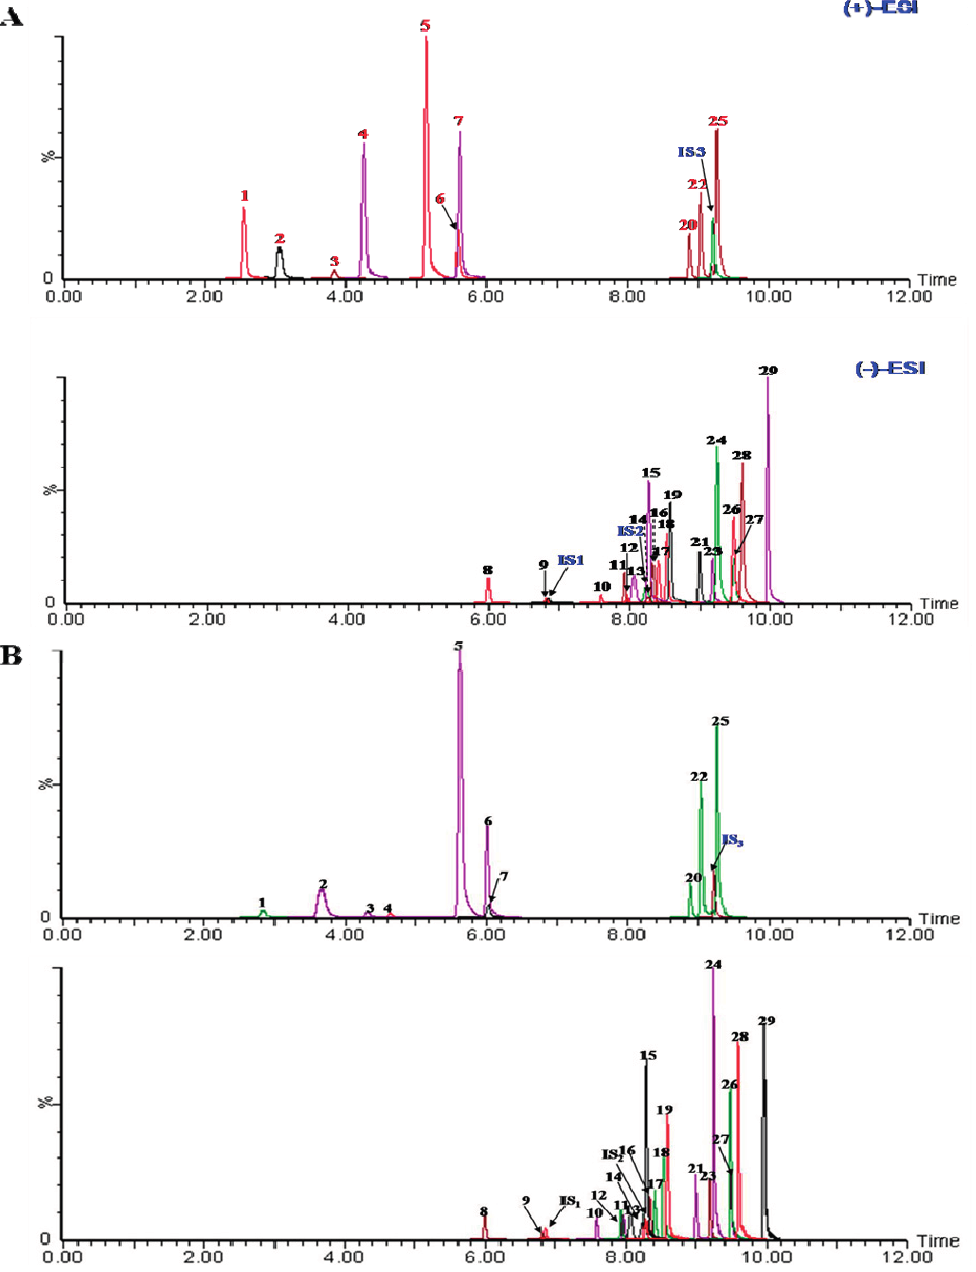
Figure 1. LC-MS/MS MRM chromatogram of 29 target standards(included 3 internal standards) ( A ) and samples ( B ): ( 1 ) protocatechuic acid; ( 2 ) neochlorogenic acid; ( 3 ) protocatechualdehyde; ( 4 ) 4-hydroxybenzoic acid; ( 5 ) chlorogenic acid; ( 6 ) cryptochlorogenin acid; ( 7 ) caffeic acid; ( 8 ) swertiamarin; ( 9 ) sweroside; ( 10 ) schaftoside; ( 11 ) agnuside; ( 12 ) isoschaftoside; ( 13 ) flavosativaside; ( 14 ) vitexin 2 ′′ -rhamnoside; ( 15 ) rutin; ( 16 ) vitexin; ( 17 ) hyperoside; ( 18 ) isoquercitrin; ( 19 ) luteoloside; ( 20 ) isochlorogenic acid B; ( 21 ) kaempferol-3- O -rutinoside; ( 22 ) isochlorogenic acid A; ( 23 ) astragalin; ( 24 ) apigenin-7- glucoside; ( 25 ) isochlorogenic acid C; ( 26 ) luteolin; ( 27 ) quercetin; ( 28 ) apigenin; ( 29 ) casticin; (internal standard 1, IS 1 ) albiflorin; ( IS ) liquiritin; ( IS ) 2-hydroxycinnamic 2 3